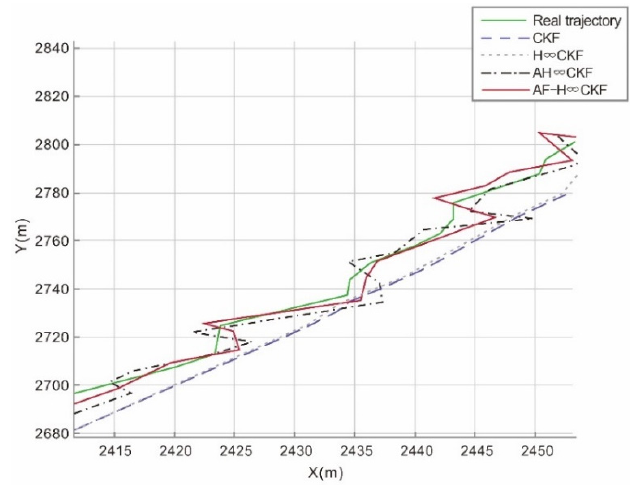
Figure 9. Partial enlargement of Figure 8.